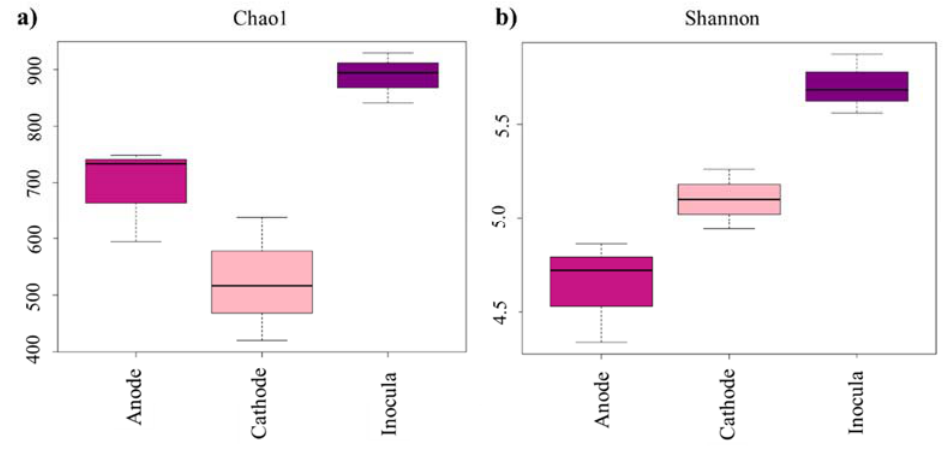
Figure 2. The microbial diversity of samples: ( a ) Chao1 index; ( b ) Shannon index. Firmicutes, Ignavibacteriae, Chloroflexi, Lentisphaerae, and Euryarchaeota